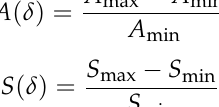
Figure 6. FRS of the raft foundation reference point in x and y direction. ( a ) FRS of the raft foundation in the x direction. ( b ) Floor response spectrum of the raft foundation in the x direction (2–10 Hz). ( c ) FRS of the raft foundation in the y direction. ( d ) FRS of the raft foundation in the y direction (2–10 Hz).